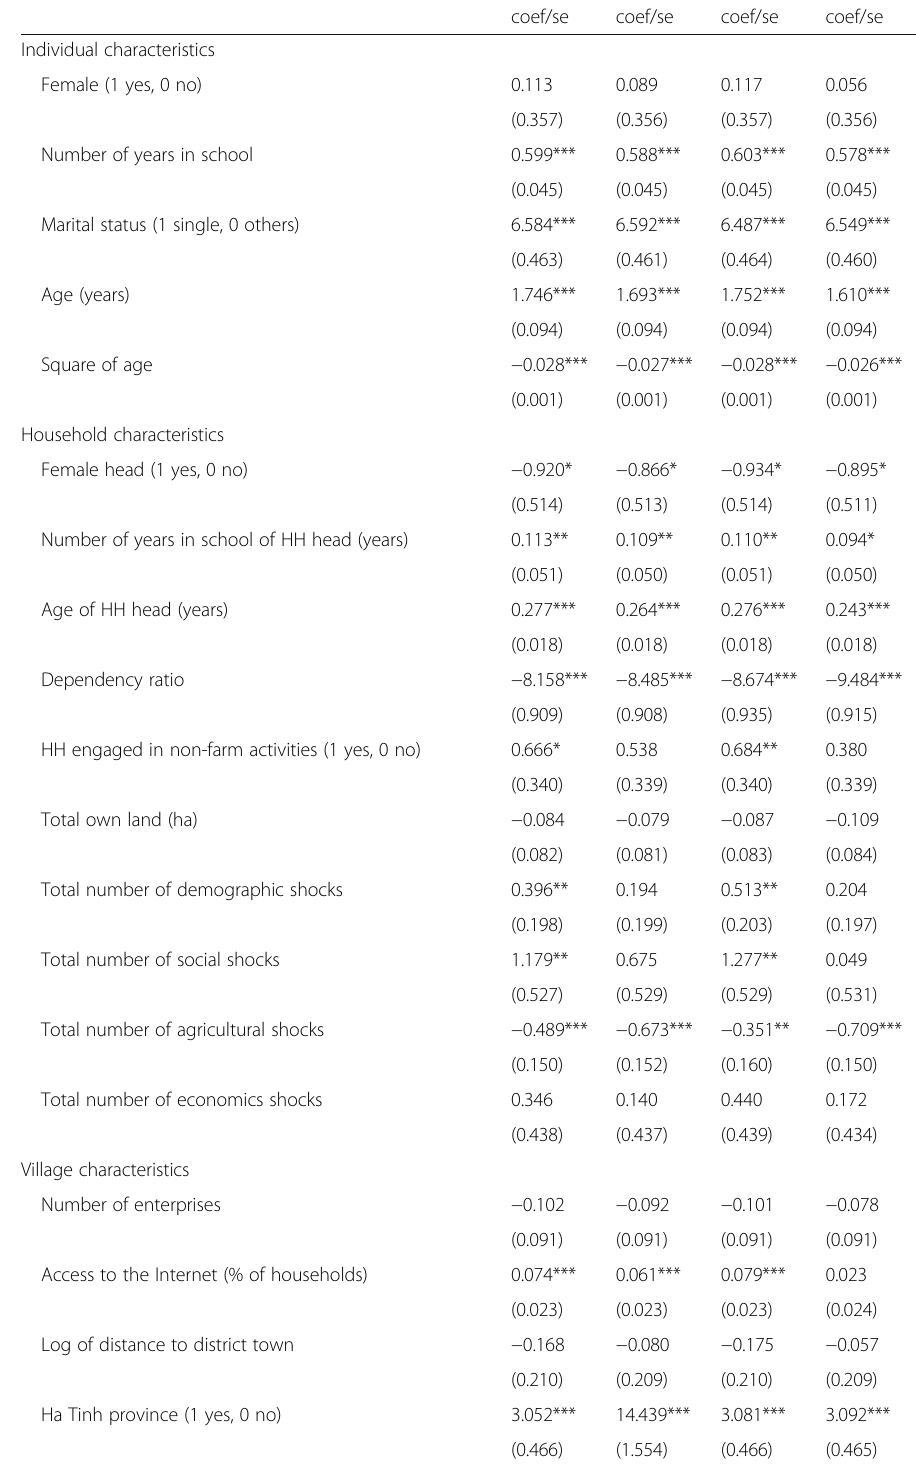
Table 2 Random-effect Tobit